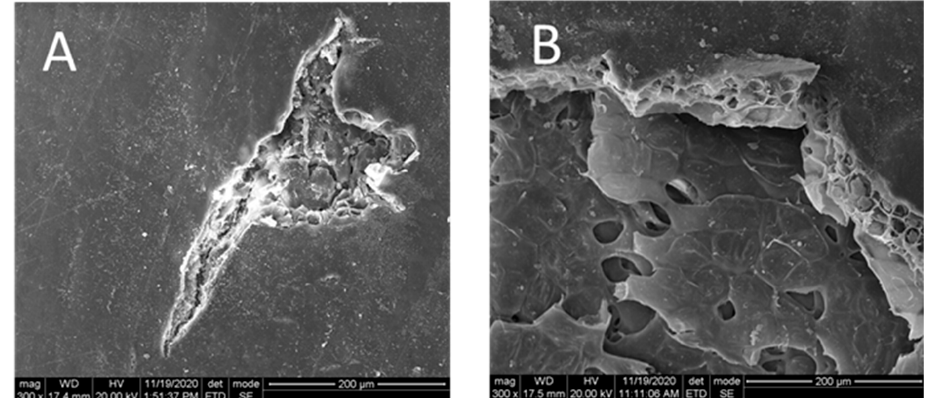
Figure 1. Ultra-microstructure of pomegranate peel by scanning electron microscope (SEM; magnification 300×). ( A ) A micro-crack in pomegranate peel; ( B ) A macro-crack in pomegranate peel.